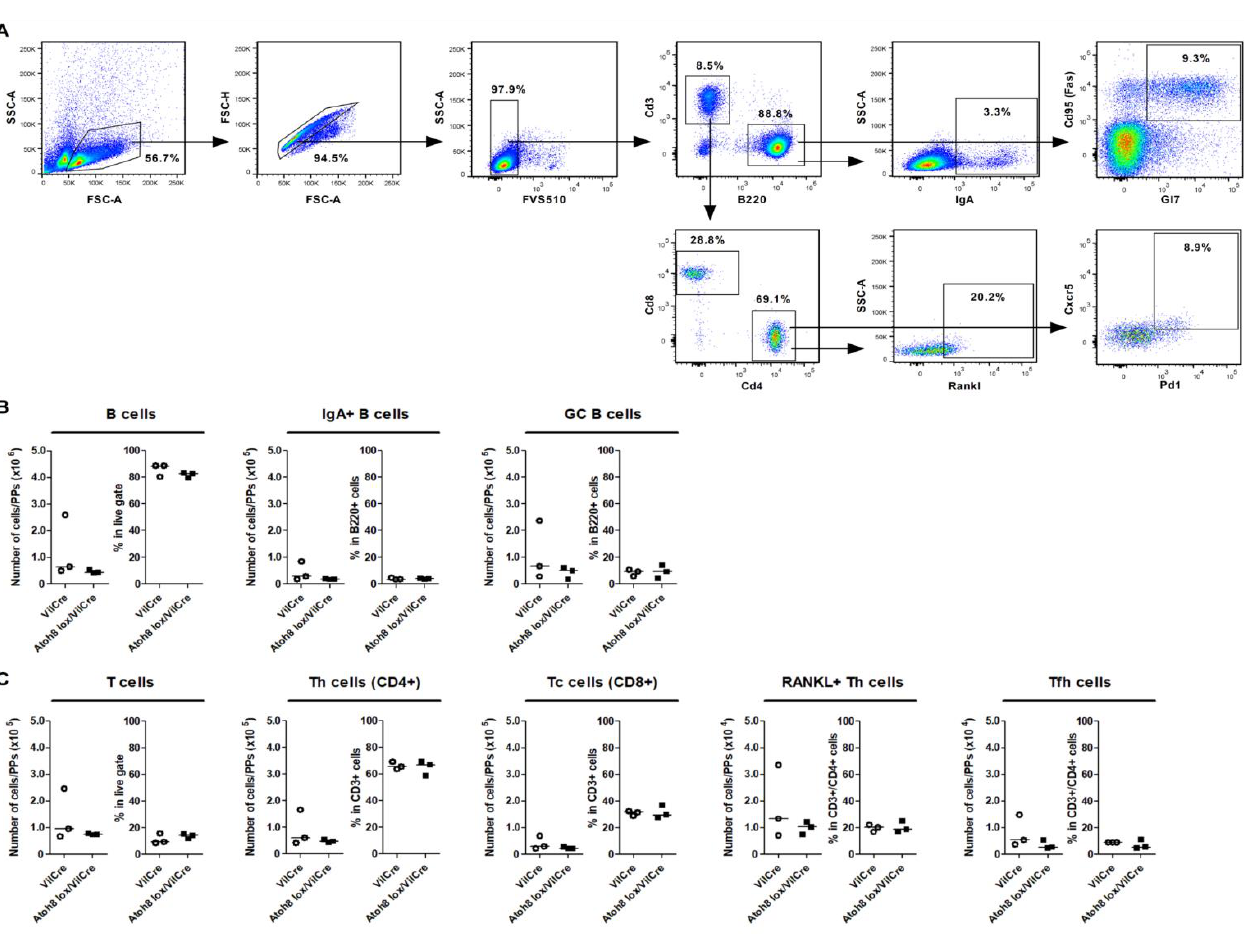
Figure 3. The loss of Atoh8 did not change the composition of lymphoid cells in 4-week-old mice after weaning. ( A ) Gating scheme for the analysis of B and T cell populations in VilCre and Atoh8 lox/VilCre ileal PPs. B (CD3 ε − B220 + ) cells were analyzed for IgA+ B and CD95+GL7+ GC B cells. T (CD3 ε +B220 − ) cells were analyzed for total CD4+ Th, CD8 α + cytotoxic T (Tc), and CD4+CD8 α − CXCR5+PD-1+ Tfh cells. ( B , C ) FlowJo analysis of indicated immune cells in ileal PPs. ( B ) Number of total B cells, GC B cells, and IgA+ B cells in 100,000 recorded cells. ( C ) Number of total T cells, Tc cells, Th cells, and Tfh cells in 100,000 recorded cells; Student’s t -test, n = 3 per group.